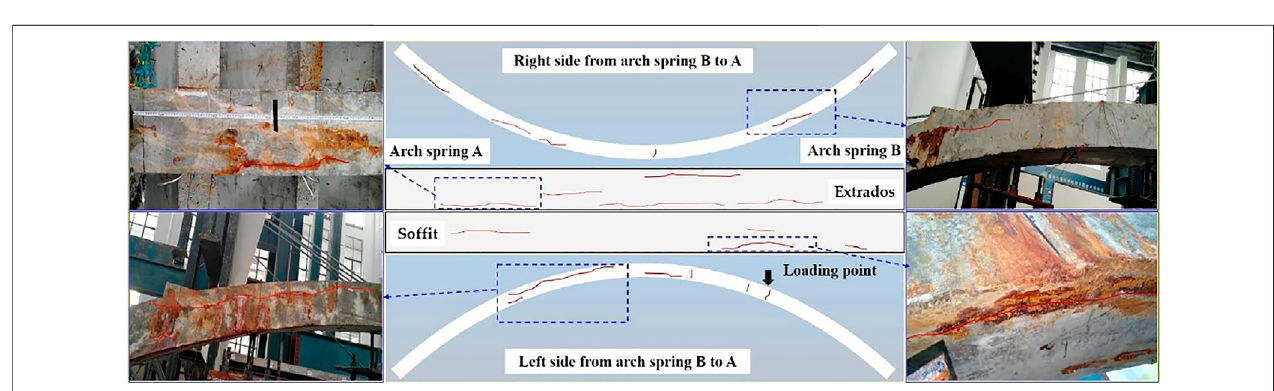
FIGURE 8 | Distribution of corrosion-induced